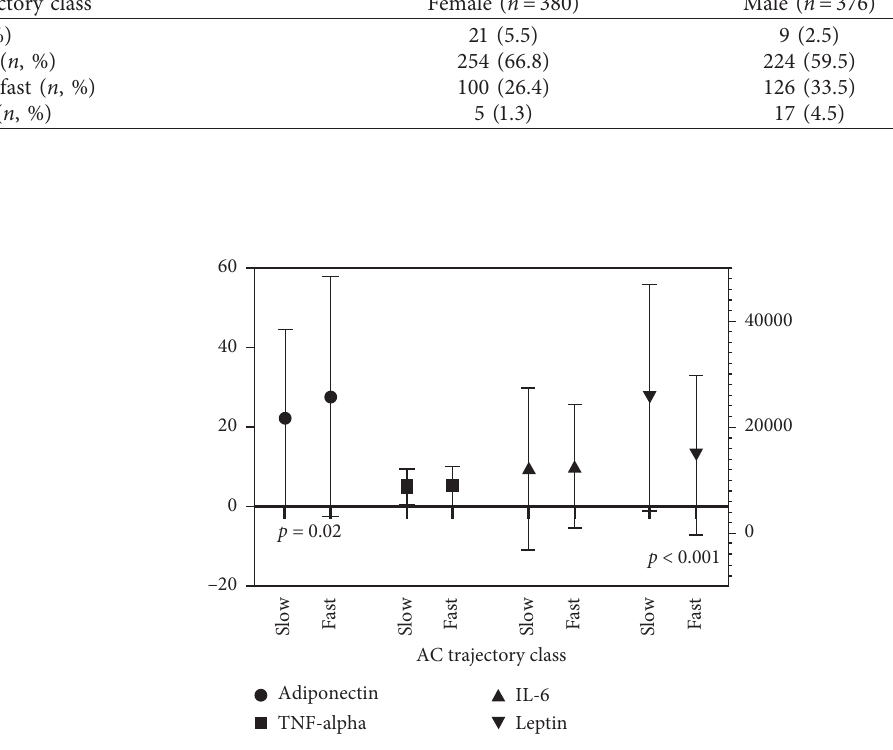
Figure 2: Maternal 28-week samples and association with abdominal circumference trajectory (slower and